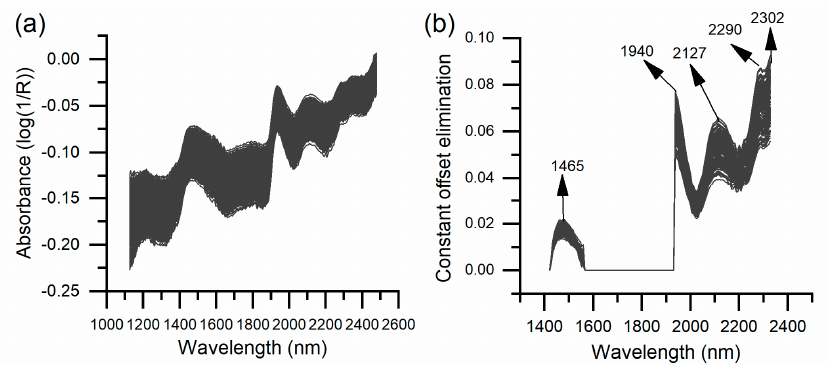
Figure 2. Near-infrared raw spectra ( a ) and vector normalized spectra ( b ) of individual rice grains.